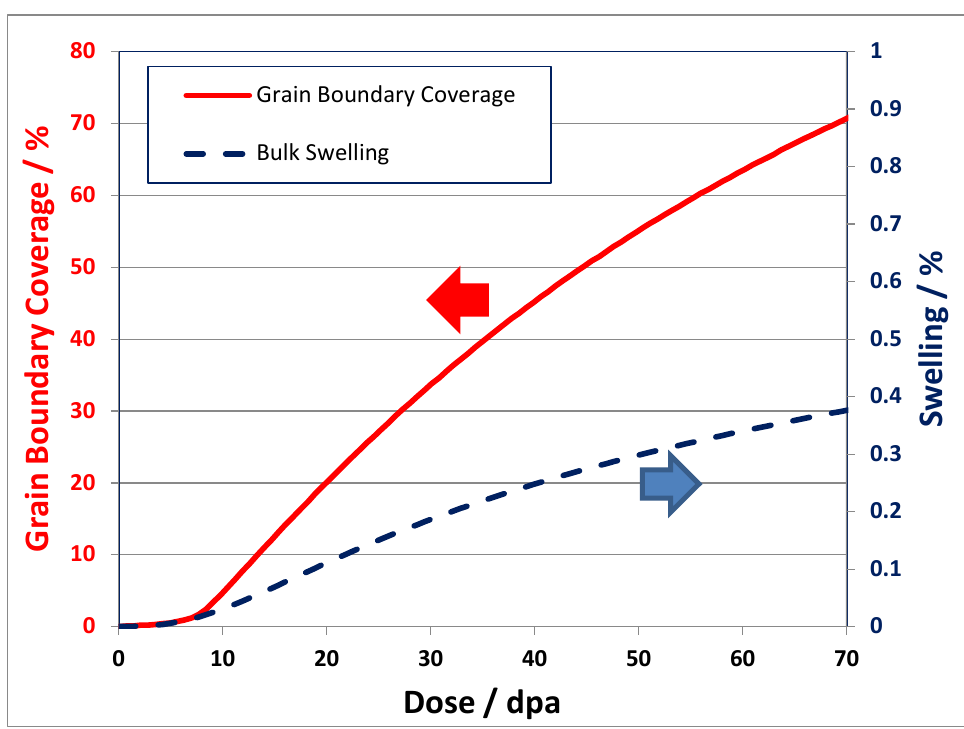
Figure 15. Calculated swelling and grain boundary area coverage for 316 SS as a function of dose (dpa) for a PWR flux thimble studied by Fukuya et al. [39] and Edwards et al. [42].